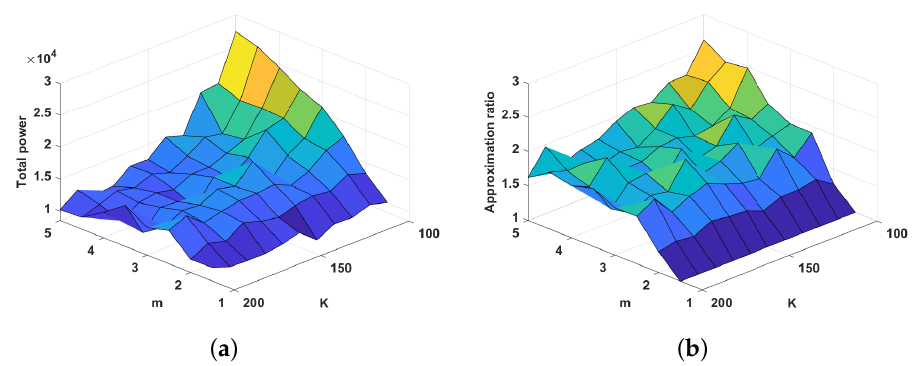
Figure 3. System performance with different numbers of servers and values of K . ( a ) Total power. ( b ) Approximation